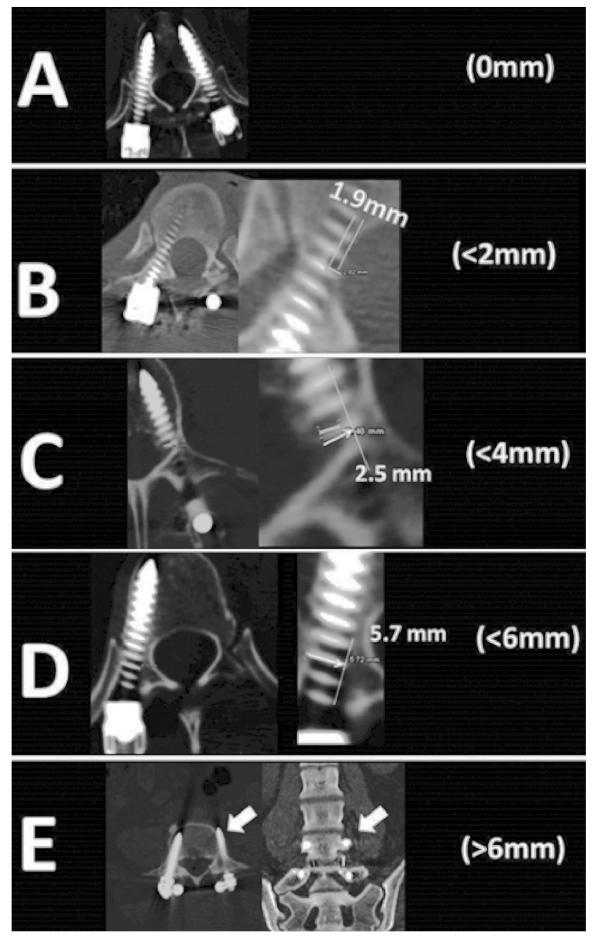
Figure 1. Computed tomography scans demonstrating the Gertzbein and Robbins classification. The grading system reflects the deviation of the screw from the “ideal” intrapedicular trajectory. The grades are as follows: A is an intrapedicular screw without breach of the cortical layer of the pedicle. B describes a screw that breaches the cortical layer of the pedicle but does not exceed it laterally by more than 2 mm. C and D reflect a penetration of less than 4 and 6 mm, respectively. We attributed Grade E to screws that do not pass through the pedicle or that, at any given point in their intended intrapedicular course, breach the cortical layer of the pedicle in any direction by more than 6 mm. Note that the screw that was marked with “D” has a deviation of more than 4 mm from the intrapedicular directory. However, in this case of a thoracic pedicle screw this deviation was intentional. Because of the very thin pedicles, we used the in-out-in technique to allow for optimal screw purchase in this case. [Derived from reference number 4 with permission].